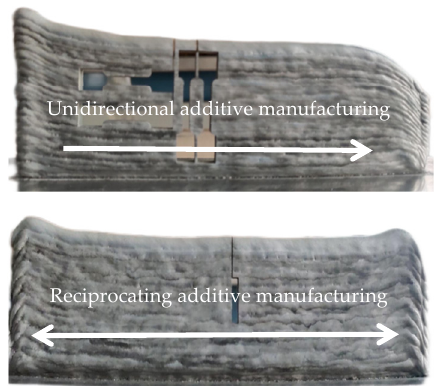
Figure 2. Al-Mg alloyed additive under different walking paths.